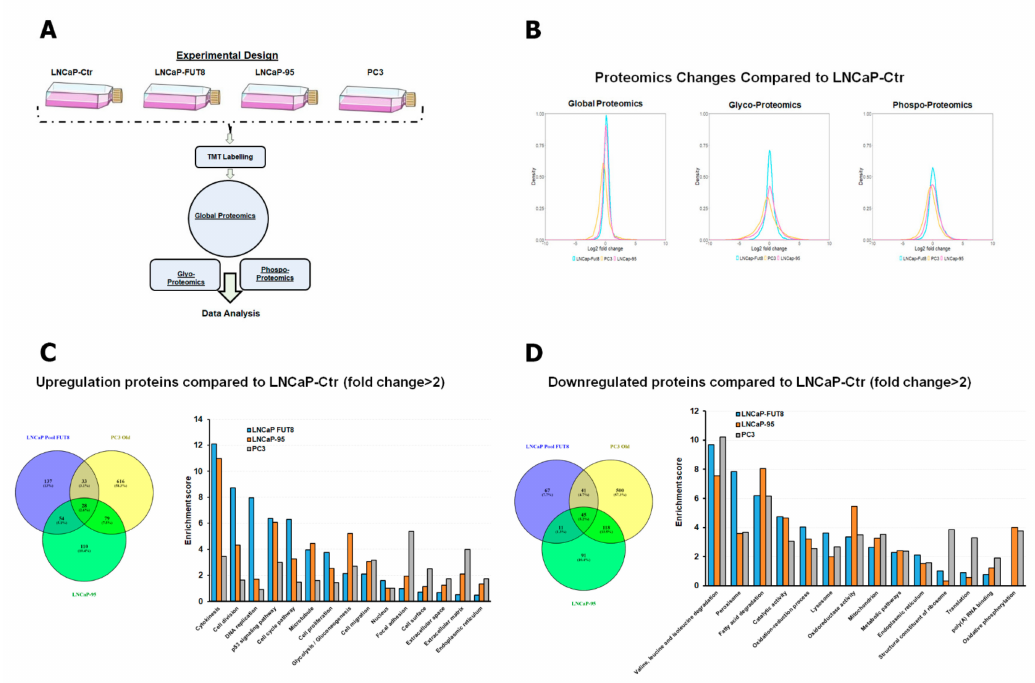
Figure 1. Characterization of LNCaP-FUT8 cells using LC–MS / MS: Schematics for proteomics strategies including Tandem mass tag (TMT) labeling, global proteomics, phosphoproteomics, and glycoproteomic to characterize LNCaP-FUT8 cells ( A ). Density distribution plots for the log 2-fold changed proteins ratio between LNCaP-FUT8, LNCaP-95, and PC3 to LNCaP ctr cells for global, phospho, and glycoproteins ( B ). Venn diagram showing the di ff erentially regulated (2-fold) global protein ratios between cells lines compared to the LNCaP-Ctr. The identified proteins were subjected to the David software (Database for annotation, visualization, and integrated discovery) to facilitate the distribution of these proteins between di ff erent cellular signaling pathways that are overexpressed ( C ) or downregulated in LNCaP-FUT8, LNCaP-95, and PC3 cells ( D